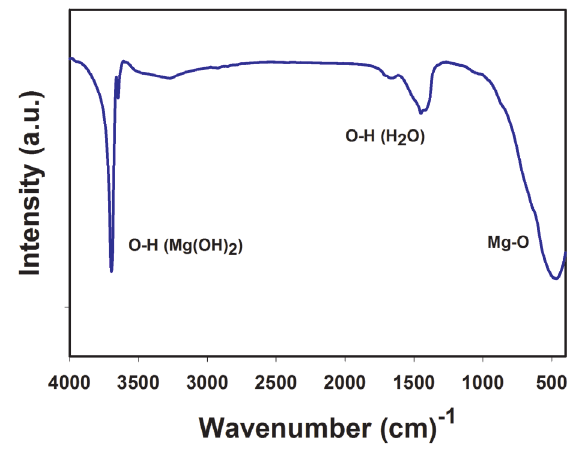
Figure 4: FT-IR of magnesium